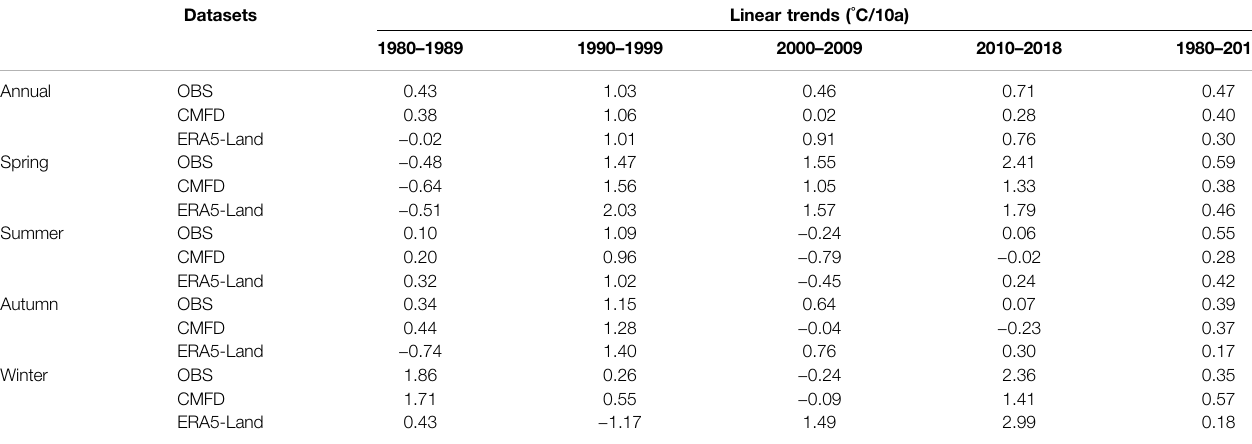
TABLE 4 | Temperature trends of the Qilian Mountains from 1980 to 2018 based on OBS, CMFD, and ERA5-Land; OBS is the average of 28 observation stations.